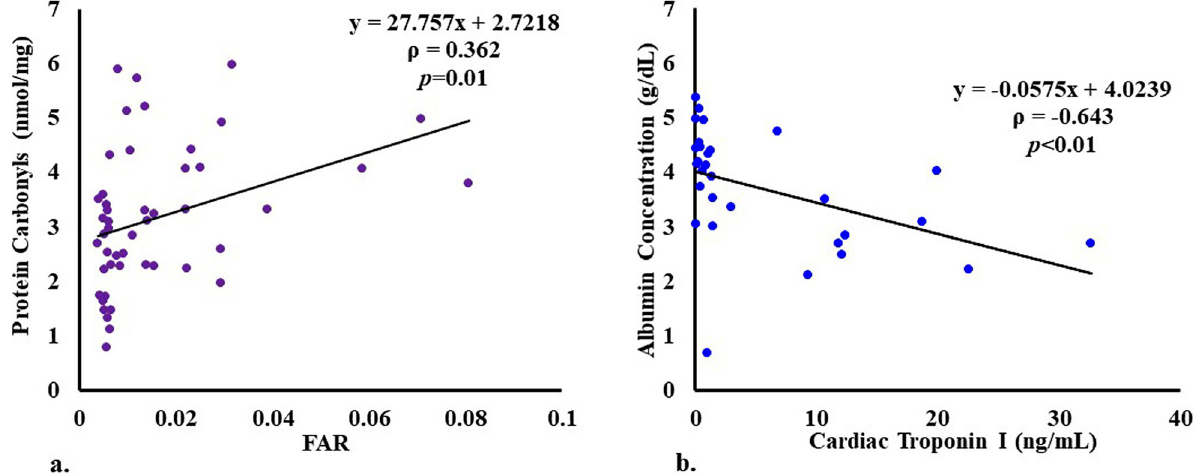
Fig 4. (a) A significant positive correlation between protein carbonyls and FAR in ACS patients with a rho value of 0.362 ( p = 0.01); and (b) a significant, strong negative correlation (rho = -0.643, p < 0.01) between serum albumin and cardiac troponin I levels in ACS cases who were brought to the hospital with acute chest pain.